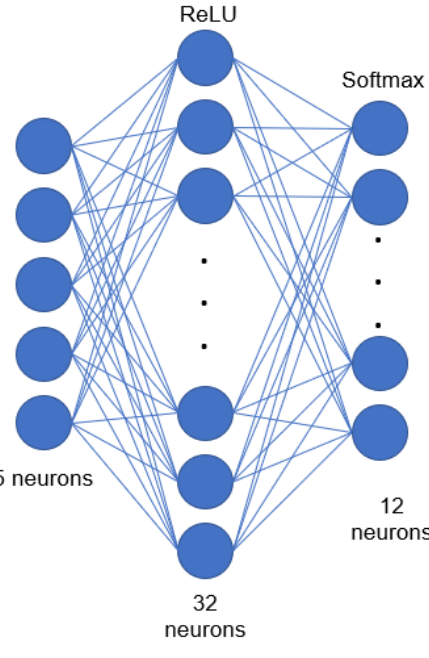
Figure 7. Proposed architecture, static neural network.